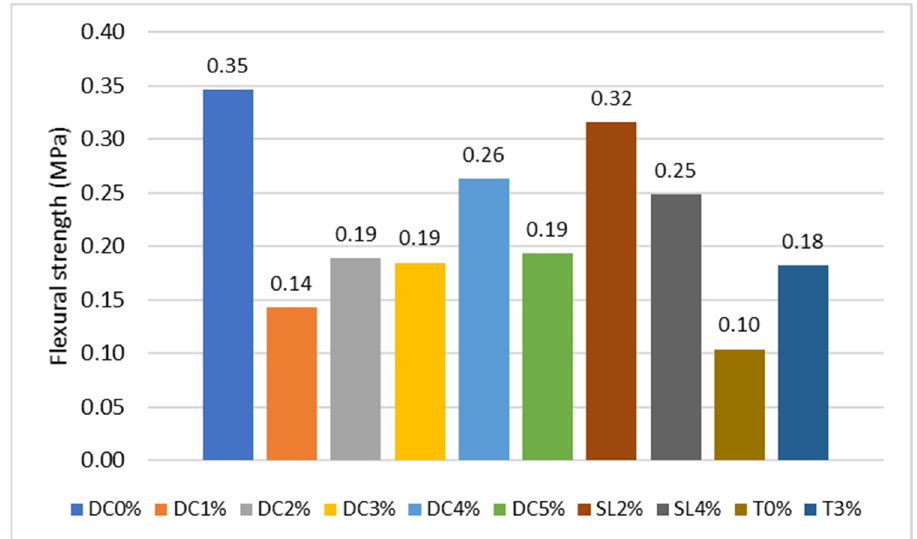
Figure 14. Flexural strength of bricks with dry fibers. Note: DCi: dynamic compaction of the sample with i (%) of fibers; SLi: static loading for sample with i (%) of fibers; Ti: tamping loading for sample with i (%) of fibers.